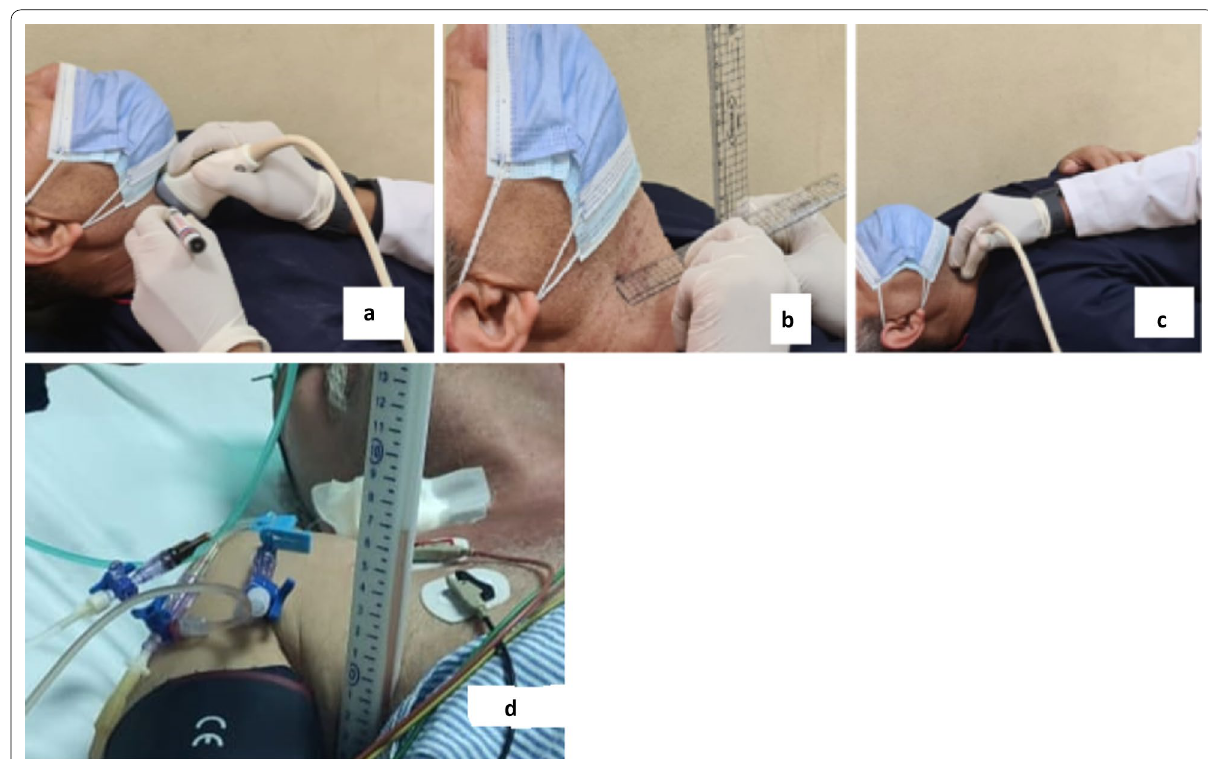
Fig. 1 a , b photographic images for demonstration of the patient position and the measurement level for the collapsing IJV point used in method 1. c A photographic image for the patient’s position used in method 2. d A photographic image for the patient position and the measurement level using the IJV catheter (CVPi) as a gold